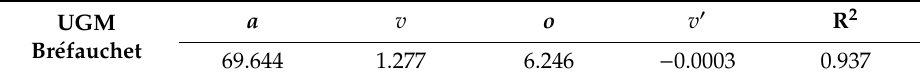
Figure 19. Test results, as well as the model prediction, for ε 1p based on suction ( S * = 2.5 kPa). Table 3. Parameters of the model based on water content.